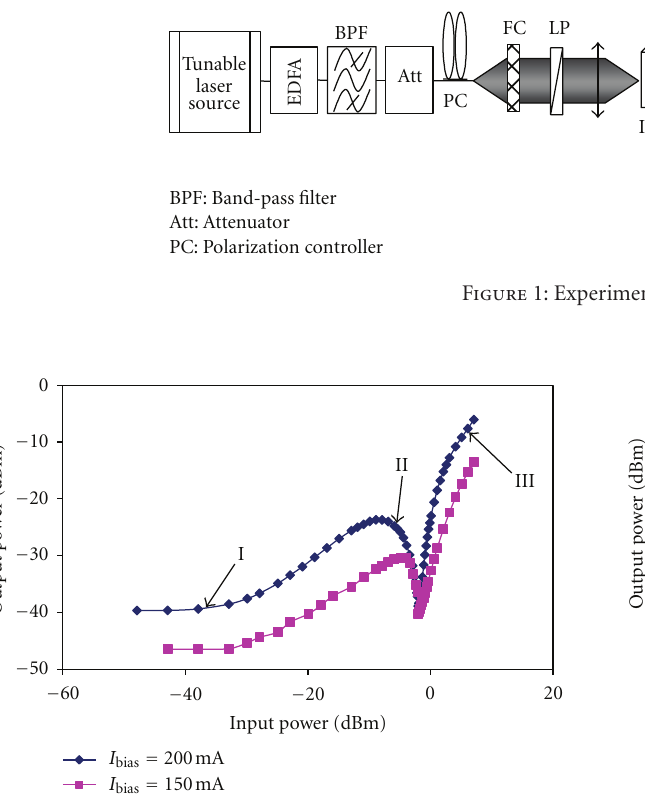
Figure 2: Measured static transfer function of the SOA at a blocking power equal to − 2 dBm and wavelength equal to 1550 nm for a bias current I bias equal to 150 mA and 200 mA.